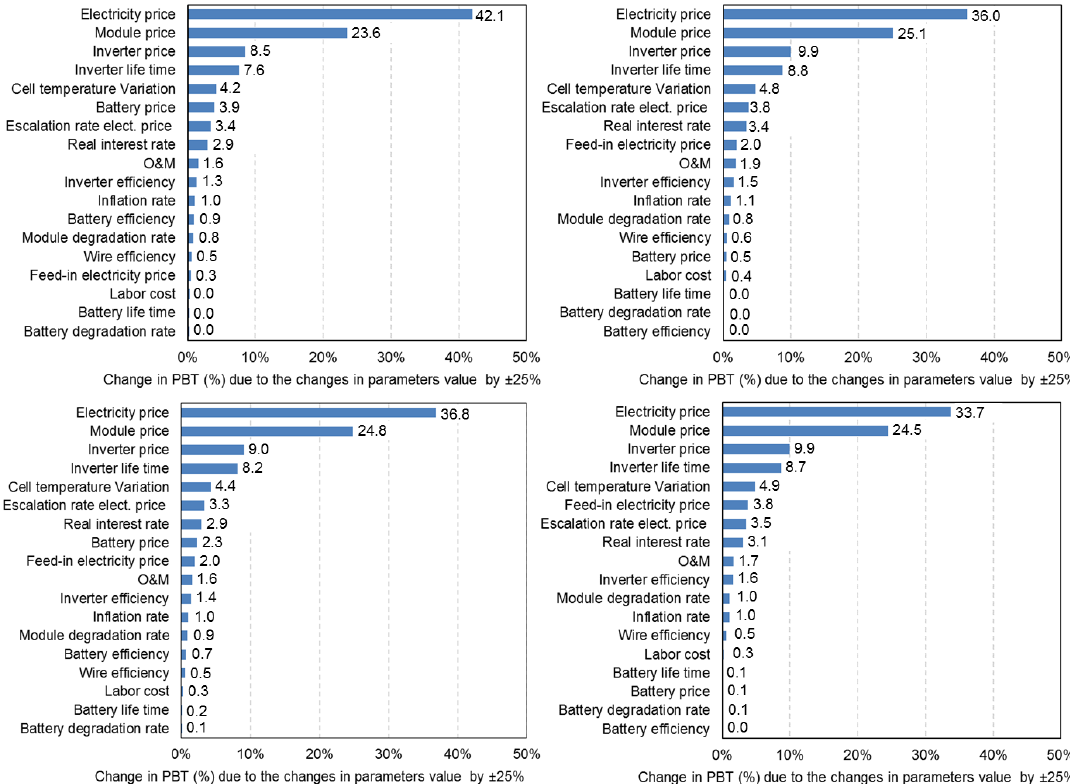
Table 2. Assumptions made in the present work.